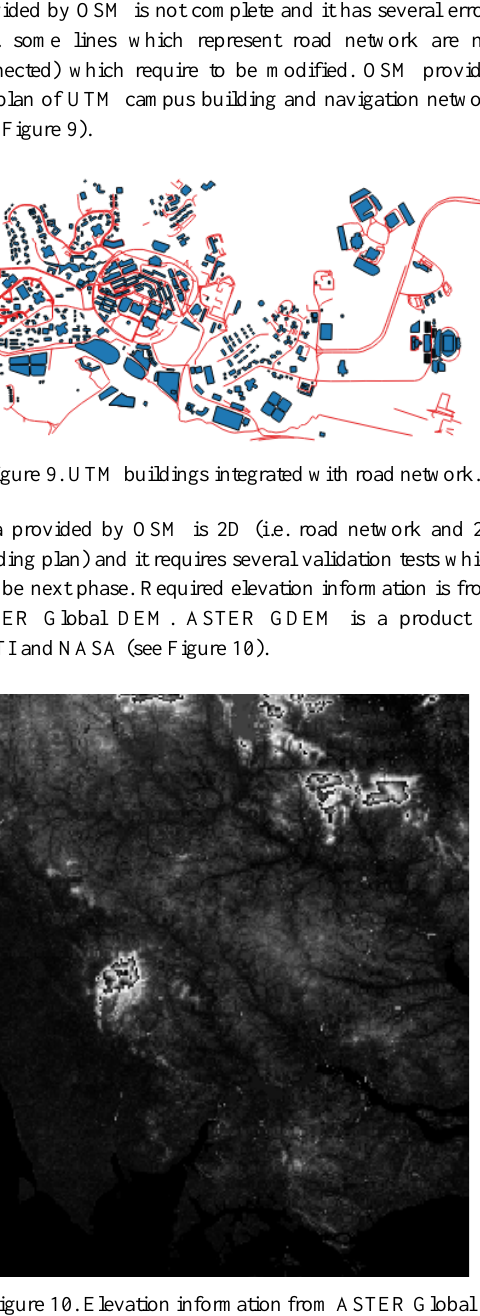
Figure 10. Elevation information from ASTER Global